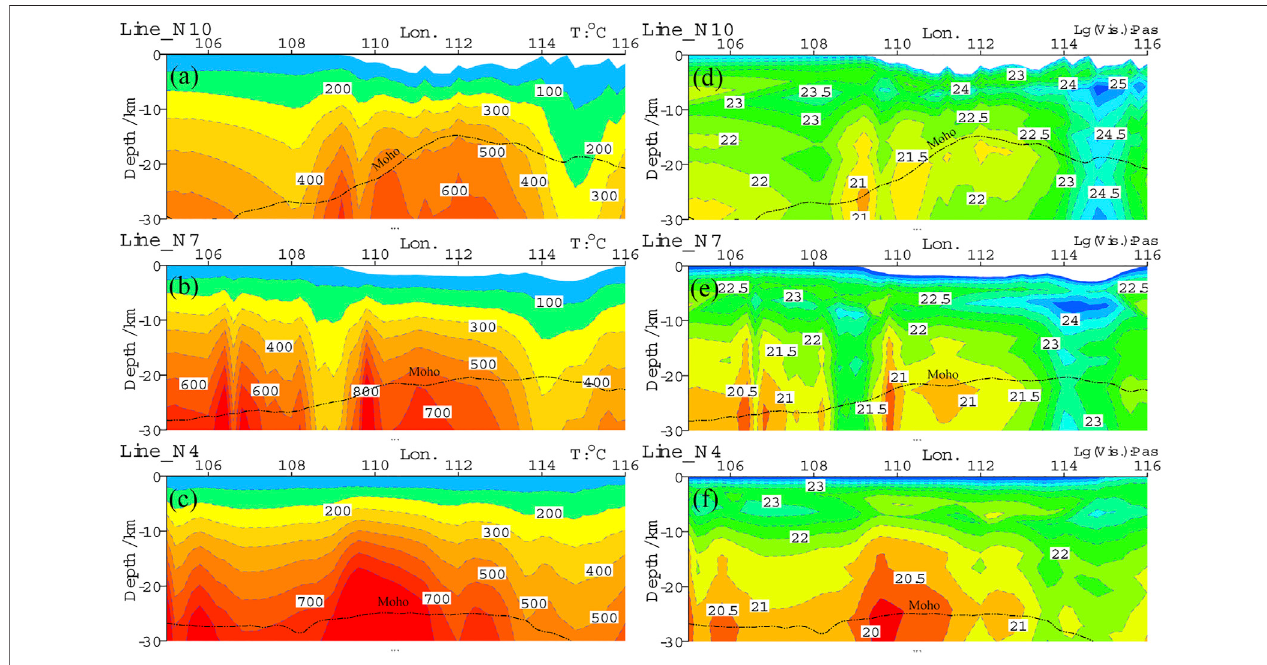
FIGURE 4 | Temperature and viscosity coef fi cient pro fi les in the southwestern margin of South China Sea. (A – C) Temperature pro fi les at Line_N10, Line_N7, and Line_N4. (D – F) Viscosity coef fi cient pro fi les at Line_N10, Line_N7, and Line_N4. The position of the pro fi les is shown in Figure 3 , and the earth surface is the starting point of